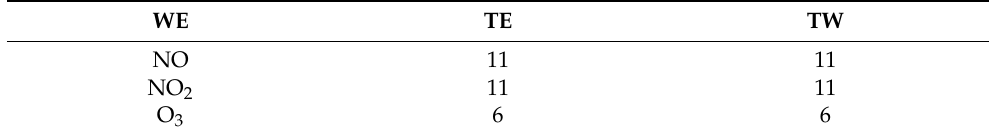
Table 5. Ranking of 2020 with the period of 2010–2020 with 1 for the highest value and 11 for the lowest value for the two Toronto stations, Toronto East (TE) and Toronto West (TW) for weekends.